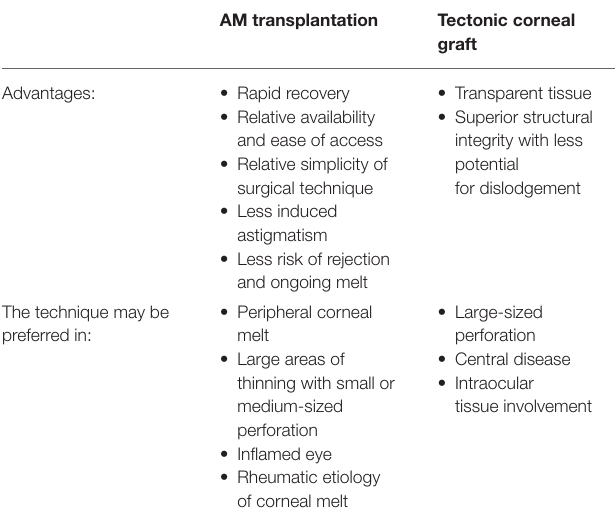
TABLE 1 | A comparison of advantages and preferred utilization of AM transplantation and tectonic corneal graft. AM transplantation Tectonic corneal